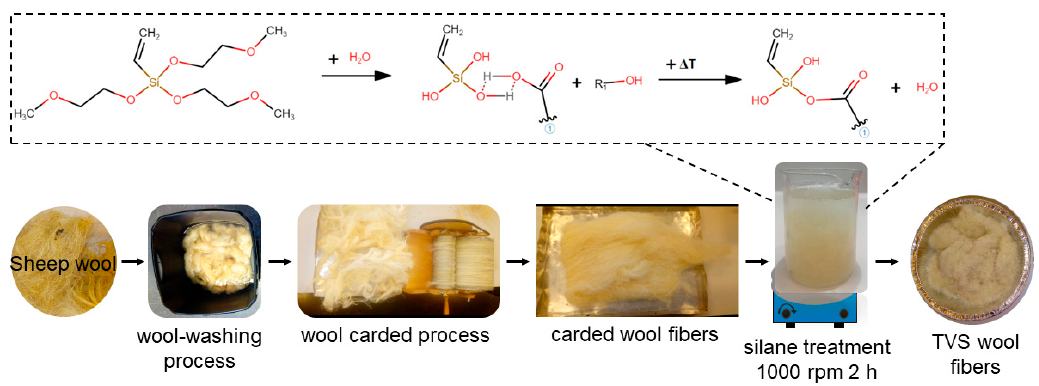
Figure 2. Schematic representation of the sheep wool fiber washing and carding process, the silane treatment with TVS, as well as the coupling reaction between TVS and wool fibers.